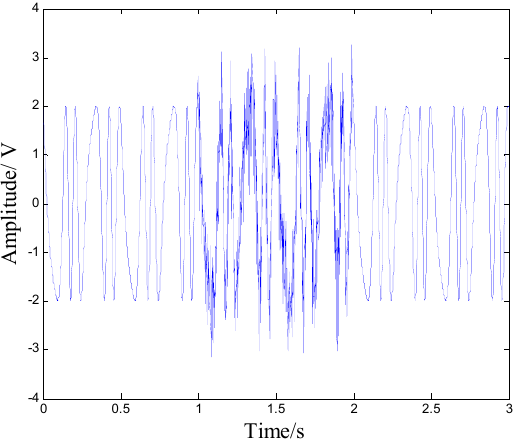
Figure 21. Time domain plot of noisy FM signal.